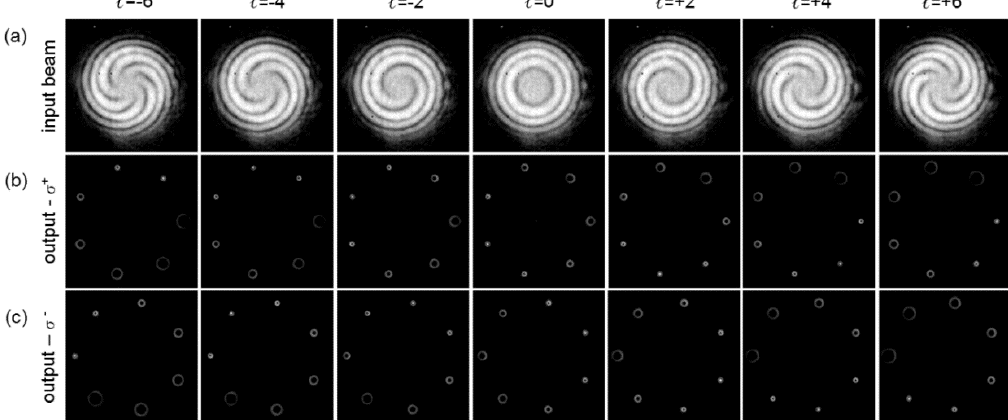
Figure 8. Optical characterization of the demultiplexer in Figure 3. ( a ) Experimental interference pattern of the input beams. The twist-handedness and number of the spiral arms reveal the sign and value of orbital angular momentum, respectively. Experimental output intensity for input right-handed ( b ) and left-handed ( c ) circular polarization states. The position of the far-field bright spots is in accordance with the channel scheme depicted in Figure 3b.